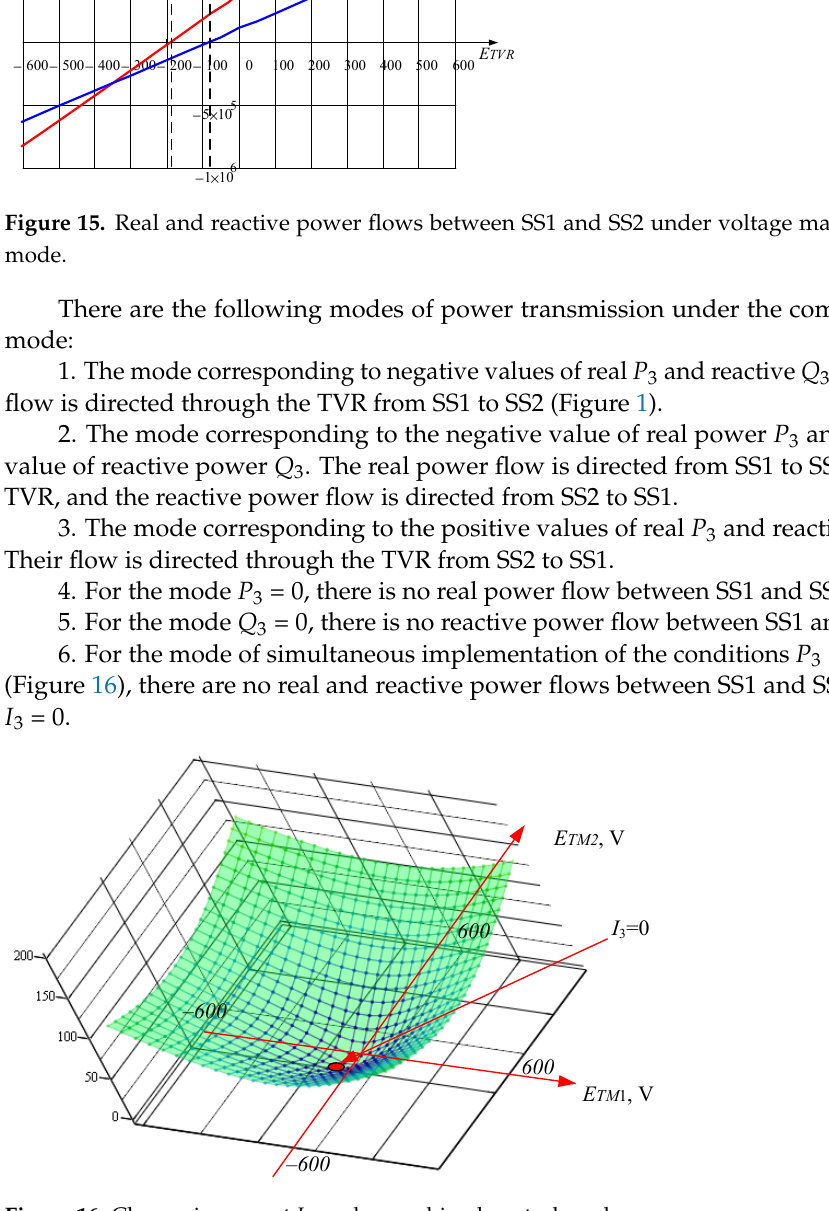
3 under combined control